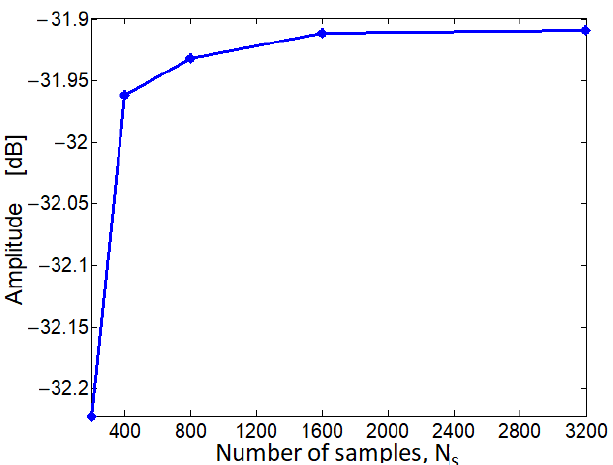
Figure 9. Maximum side lobe level (in dB) as a function of the number of samples, for 𝑁 = 20 , 𝑢 𝑀𝐵 = 0.16 , and Δ𝑢 = 0.7